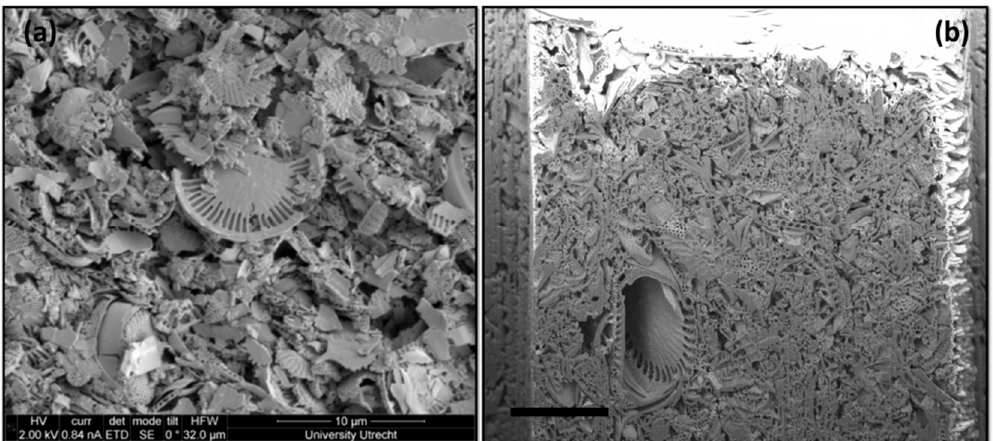
Figure 1. ( a ) SEM image revealing the surface of the diatomite sample; ( b ) BSE (backscattered electrons) image of cross section from serial sectioning process, scale bar is 5 µm. The saturated contrast concerns the in situ Pt deposition in BSE imaging.